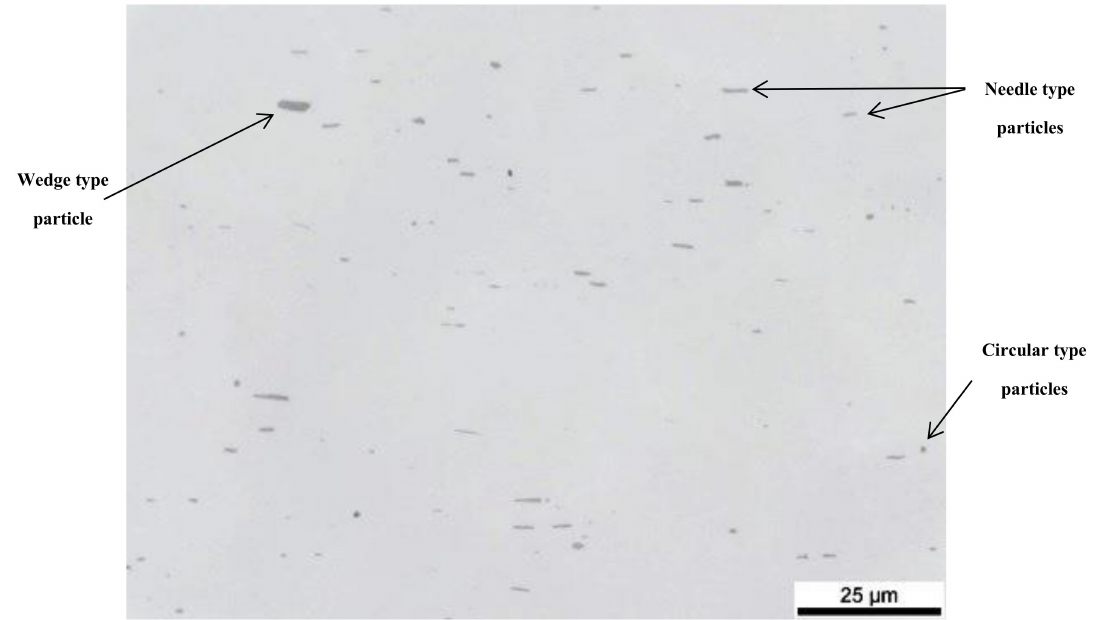
Figure 2. Optical micrograph showing intermetallic particles in Al 6063 alloy sample (observation parallel to extrusion). Wedge, needle and circular type particles can be